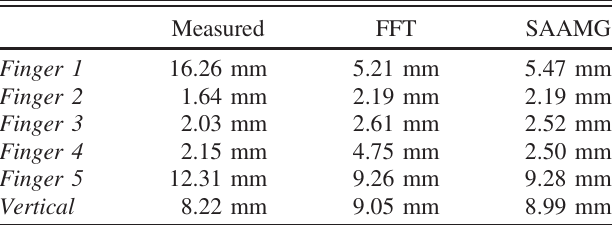
TABLE II. Full width at half maximum (FWHM) for the measured distribution and the OPAL results using the FFT and the SAAMG solver.